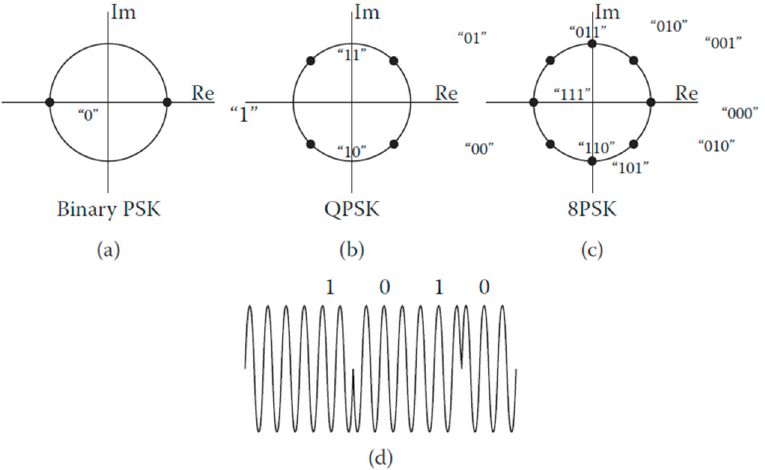
Figure 10. Signal-space constellation of discrete PM: ( a ) binary PSK, ( b ) quadrature binary PSK, ( c ) eight PSK and ( d ) phase of the carrier under modulation with π phase shift of the BPSK at the edge of the pulse period. From: [119] , Copyright © 2015 and Imprint. Reproduced by permission of edge of the pulse period. From: [119], Copyright © 2015 and Imprint. Reproduced by permission of Taylor & Francis Group through PLSclear. Taylor & Francis Group through PLSclear.